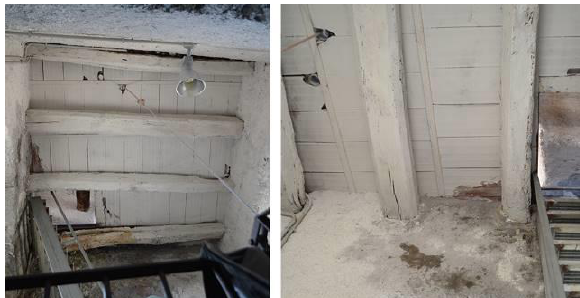
Figure 9. Intermediate floor in the bell tower of San Giovanni in Bronte (Ct).